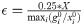
Productivity as a function of the grant call k, for different scientific policies.The colors green, yellow, blue and red denote, respectively, the modified gradient scheme, the average rates scheme A, the rule of three and the standard scheme. Starting from a random distribution of funds, we study the performance of different policies under increasing amounts of statistical noise. For both the modified gradient scheme and the average rates scheme A, we chose ϵ=0.25*Xmaxi(gi0/xi0). If each term lasts s = 4 years, then, in all cases, the rule of three would require 12 years to steer the community to a configuration where the average scientific production is greater than 90% of the maximal value.